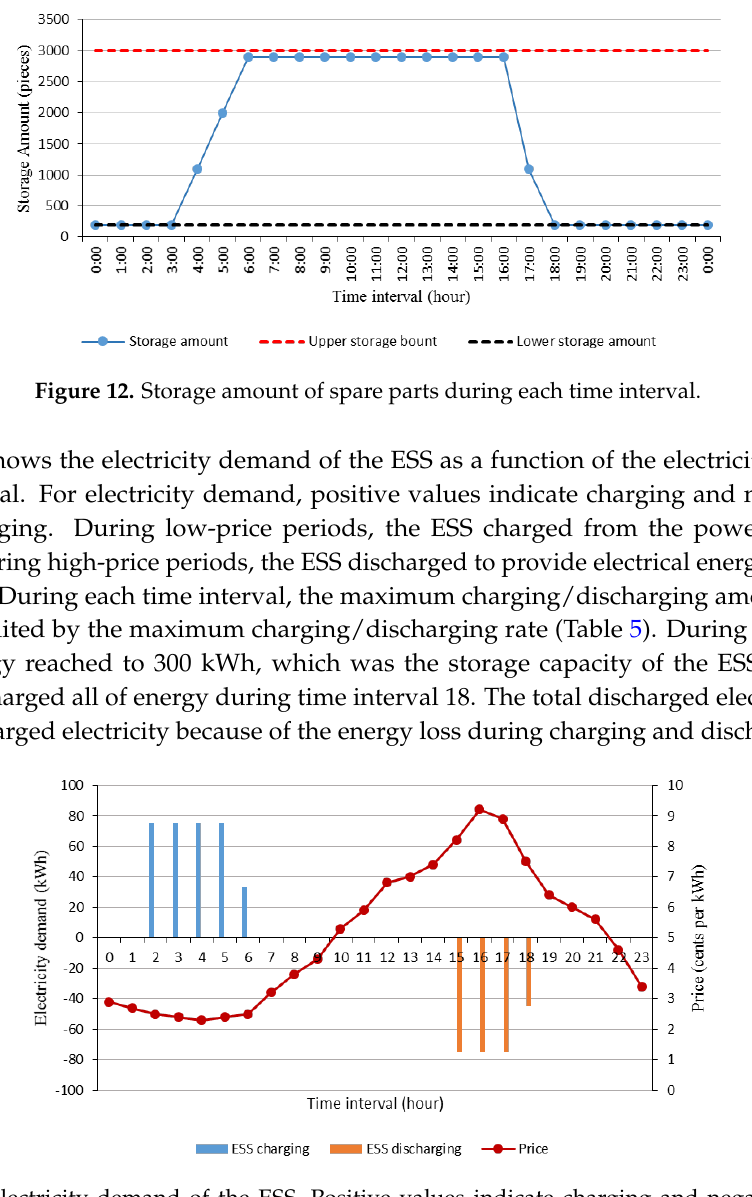
Figure 13. Electricity demand of the ESS. Positive values indicate charging and negative values indicate discharging.